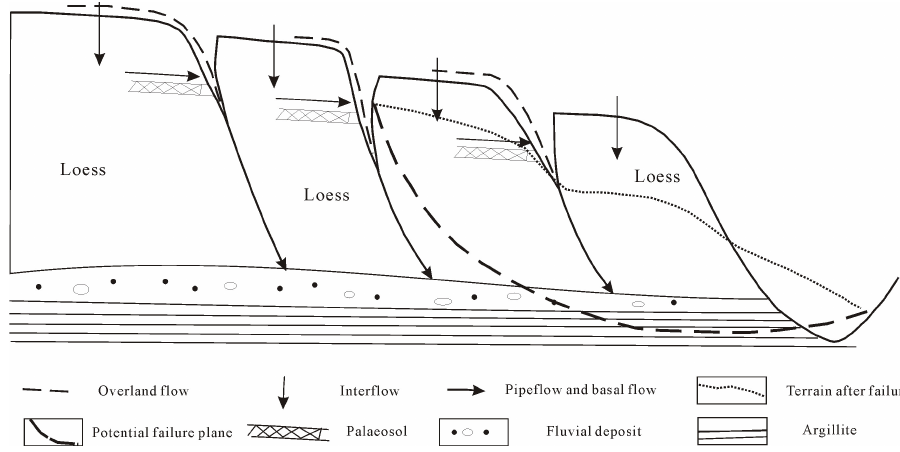
Fig. 6. Schematic model of water routing in loess at the study area.